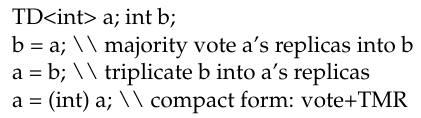
Table 4. Example of triplicating and voting automation for two hardened and non-hardened